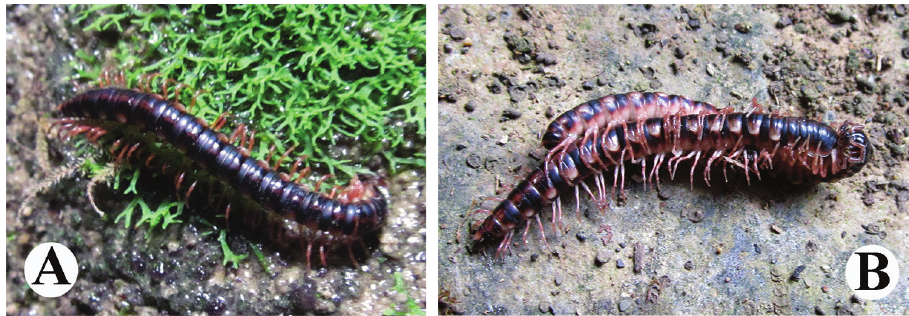
Figure 1. Tonkinosoma flexipes Jeekel, 1953 in nature. A a ♂ B a mating